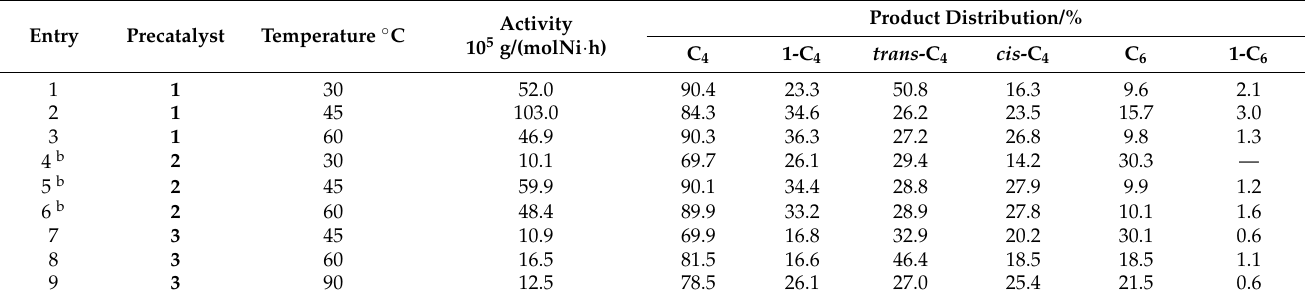
Table 5. Effects of temperature for precatalysts 1 – 3 on ethylene oligomerization a